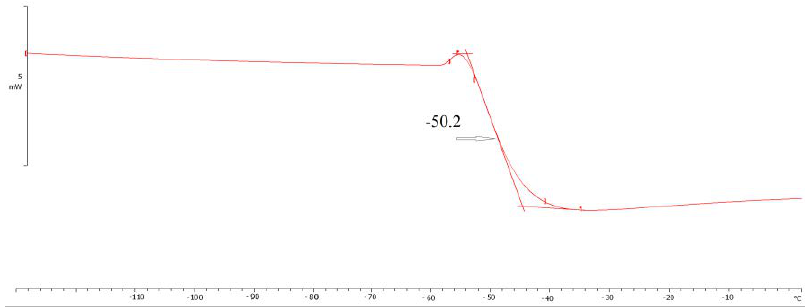
Figure 8. DSC thermogram of PVC composition containing DBEA.